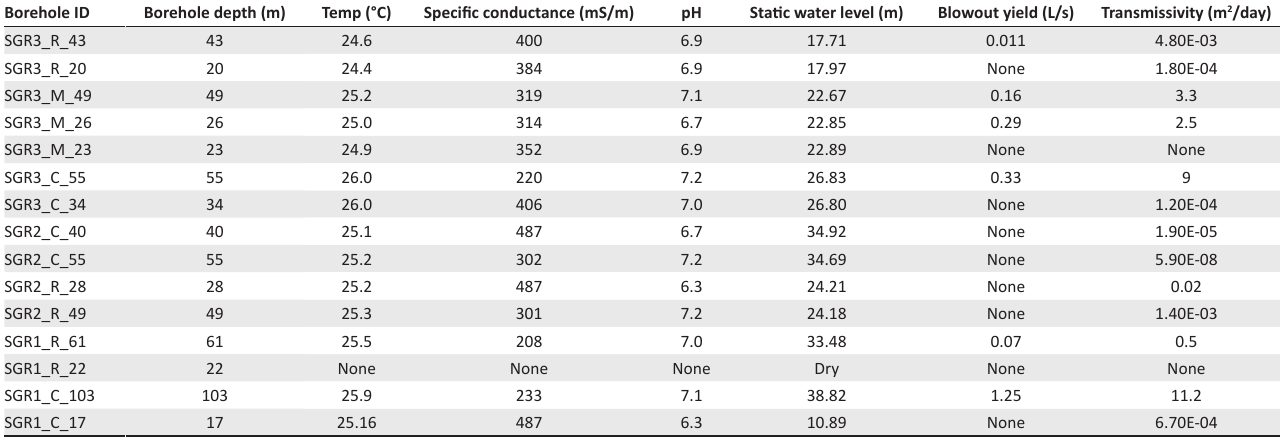
FIGURE 2 (Continues ...): Electrical resistivity tomography distribution for the three hillslope stream orders at the Southern Granite Supersite (where 1, 2 and 3 represent Southern Granite Supersite 1, Southern Granite Supersite 2 and Southern Granite Supersite 3, respectively). TABLE 1: Borehole hydraulic parameters determined following drilling during 2012. (SGR1, SGR2, SGR3 = first, second and third Southern Granite Supersite orders, respectively. Meanwhile C, M and R = crest, midslope and riparian, respectively). Borehole ID Borehole depth (m) Temp